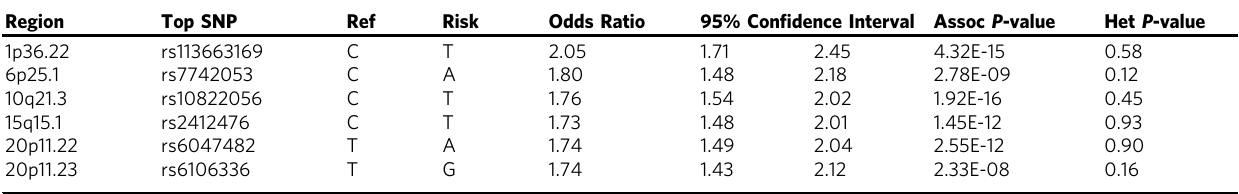
Table 1 Magnitude and strength of association for previously published and new EWS susceptibility loci Region Top SNP Ref Risk Odds Ratio 95% Con fi dence Interval Assoc P -value Het P -value 1p36.22